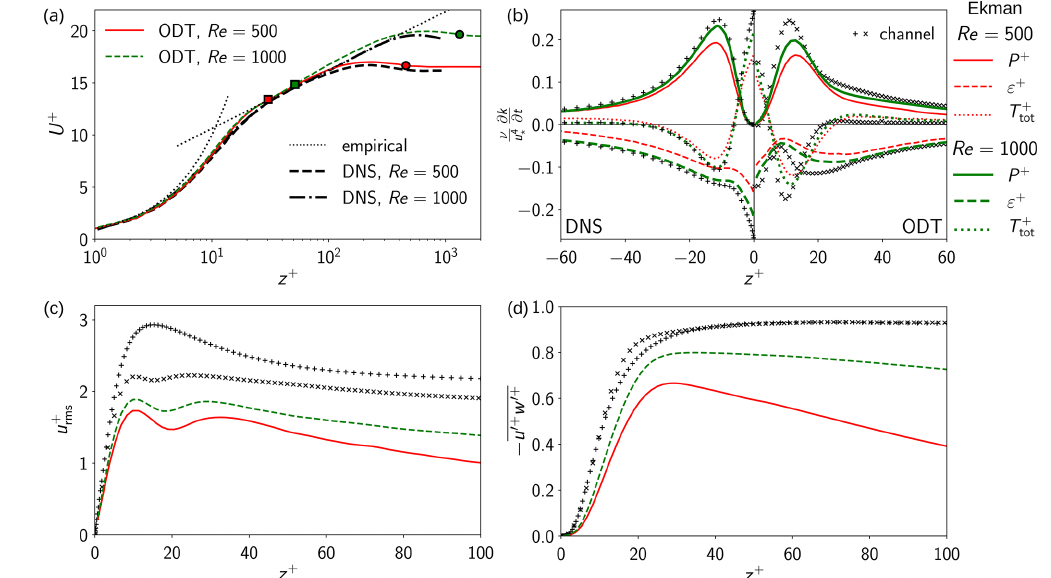
Figure 4. (a) Law-of-the-wall plot of the normalized temporal-averaged geostrophic (streamwise) velocity U + = U/u ∗ over the stretched vertical coordinate z + = zu ∗ /ν . Empirical relations are given for the viscous sublayer close to the surface and the log layer at finite distance from the surface according to Eqs. (18) and (19). Symbols mark the locations corresponding to the laminar Ekman layer thickness z + = D + ( (cid:3) ) and the turbulent Ekman layer thickness z + = δ + ∗ ( ◦ ), respectively. ODT simulation results have been obtained for the cases N500 (thin , 0 lines) and N1000 (thick lines) detailed in Table 2. Colors encode the model parameter selections in accordance with Fig. 3. Corresponding reference DNS are from Ansorge and Mellado (2014). (b) “Back-to-back plot” of the turbulence kinetic energy (TKE) budget for fully developed Ekman flow under neutral conditions in comparison to reference DNS (Lee and Moser, 2015) and ODT (Klein et al., 2022) results for turbulent channel flow for Re τ = 2000. (c) Normalized streamwise fluctuation velocity u + rms and (d) eddy covariance u (cid:48)+ w (cid:48)+ for ODT Ekman flow (lines) in comparison to ODT ( × ) and DNS ( + ) channel